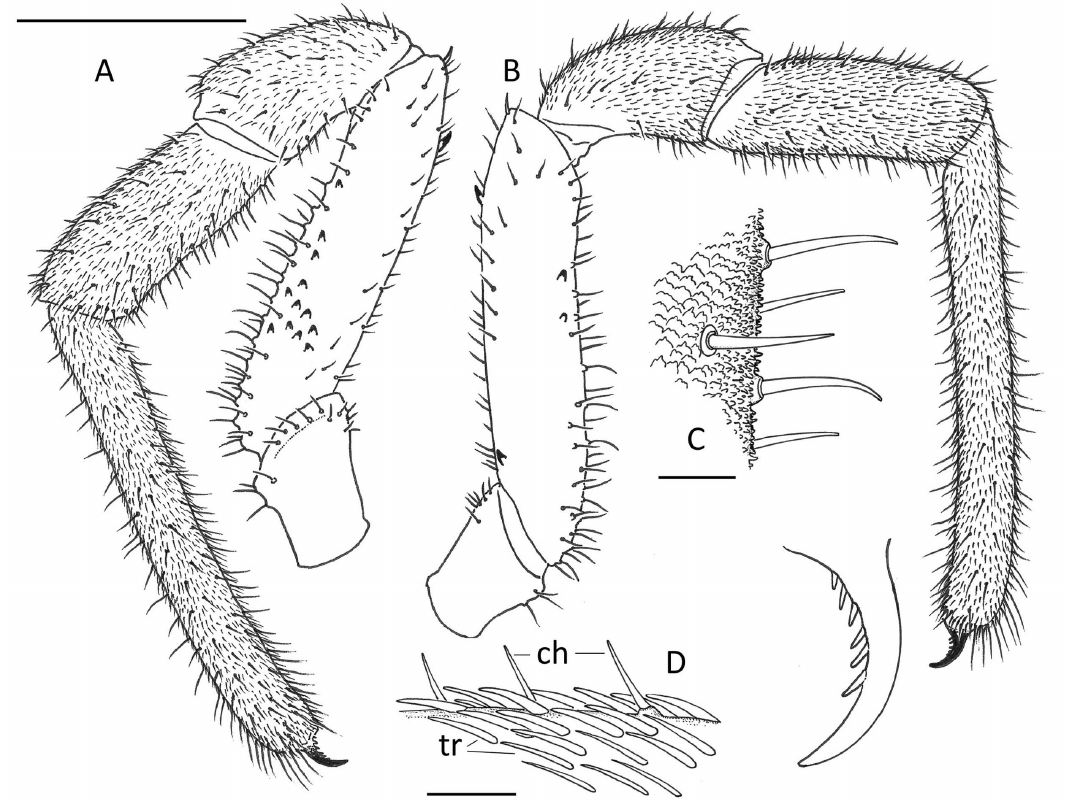
Fig. 5. Right male pedipalp of Leiolima iberica gen. et sp. nov. (holotype, MNCN 20.02/17372). A . Median view. B . Lateral view with detail of claw. C . Detail of ventral side of femur showing sensilla chaetica and imbricate microsculpture. D . Detail of dorsal side of patella showing robust trichomes (tr) and sensilla chaetica (ch). Scale bars: A–B = 0.5 mm; C–D = 0.05